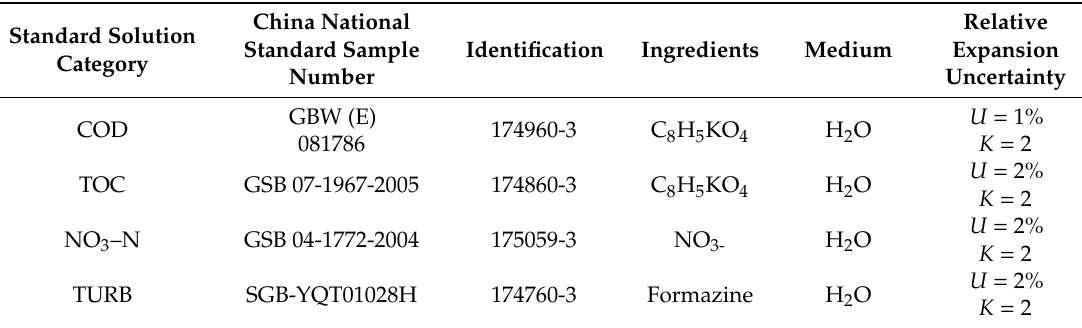
Table 2. Standard solutions for testing the instrument.